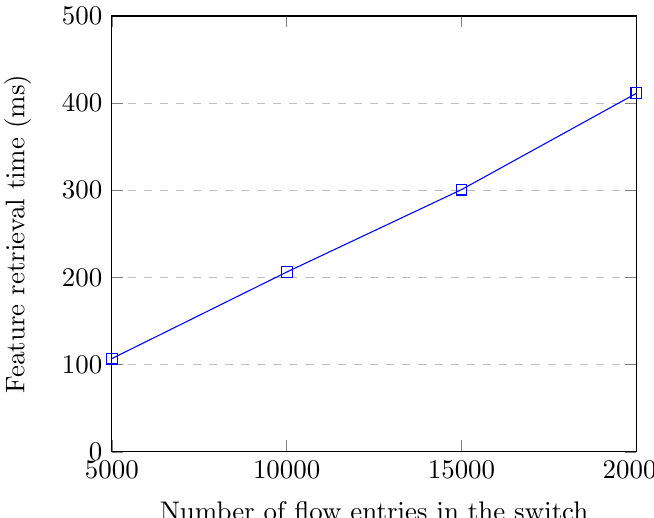
Figure 7. Feature retrieval time up to 1000 flow entries.